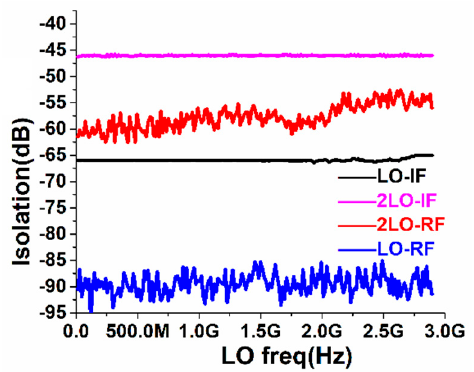
Figure 20. The measured port-to-port isolation.